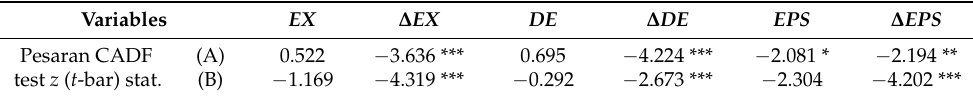
Table 2. Results of Panel Unit-root